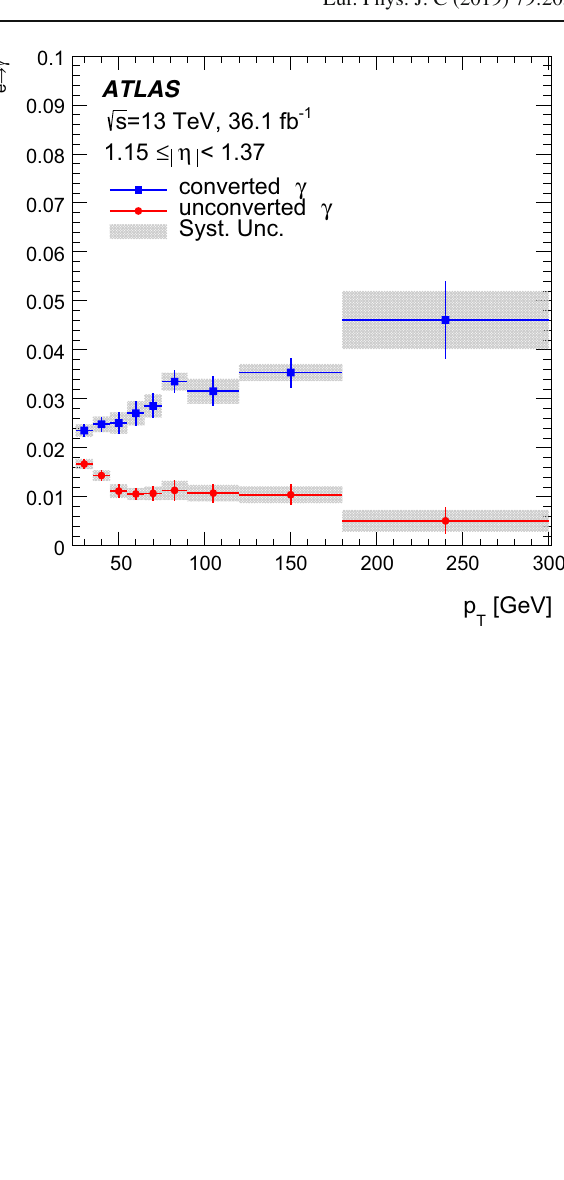
Symbols with error bars correspond to the results with their total uncer- tainties, and gray shaded areas correspond to systematic